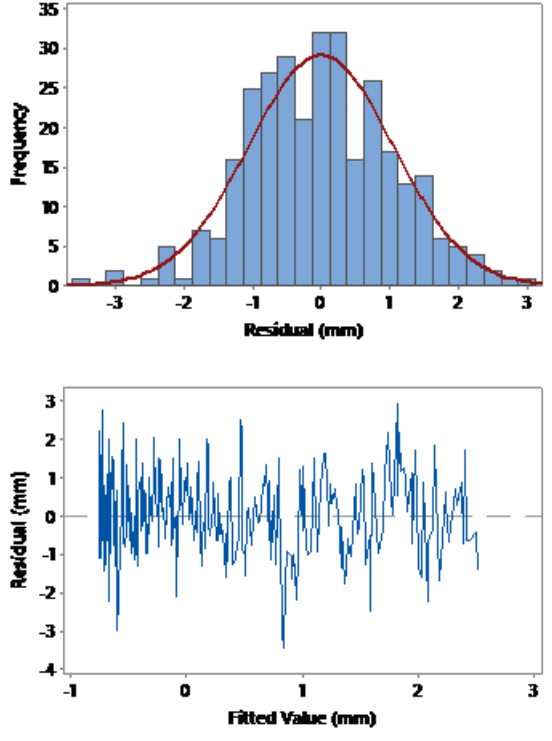
Fig. 3. Residuals of the baseline kinematic model solution exhibit unmodeled episodic excursions. They correlate well with MEI (Iz and Shum